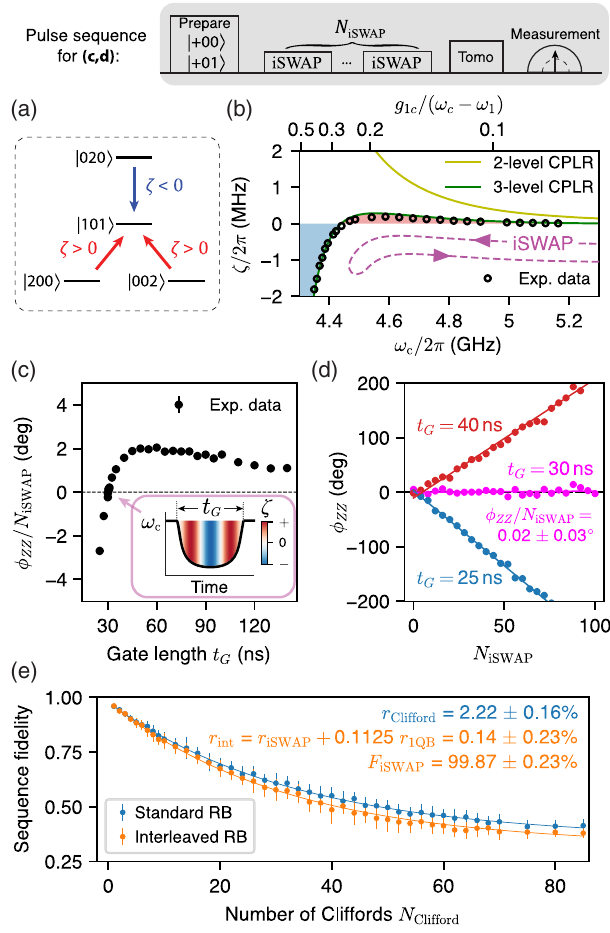
FIG. 5. Canceling out residual ZZ interaction of the iSWAP by exploiting the engineered coupler level structure. (a) The residual ZZ interaction during iSWAP originates from the level repulsion between j 101 i and the second excited level of the qubits (red arrows). This level repulsion is counteracted by utilizing the level repulsion from the second excited state of the coupler (blue arrow). (b) Residual ZZ strength ζ as a function of the , when the two qubits are on resonance. The coupler frequency ω c top x axis shows the corresponding perturbation parameter − ω = ð ω g 1 1 Þ . The solid curves correspond to numerical sim- c c ∞ (yellow) or η = 2 π ¼ − 90 MHz ulation assuming either η c ¼ c =N as a (green). (c) ZZ angle of the iSWAP gate ϕ ZZ iSWAP . We cancel out the ZZ angle by function of the gate length t G exploiting the tunability of ζ from positive to negative values. The inset shows the dynamic change of ζ during the excursion of ω c for a 30-ns-long iSWAP gate. Each data point is obtained by fitting the accumulated ZZ angle ϕ of N -times repeated ZZ iSWAP iSWAP gates with a linear function as shown in (d). (e) The results of interleaved RB for the ZZ -free 30-ns-long iSWAP gate (see the main text for details). We measure 30 random sequences ). Error bars represent (cid:1) 1 for each sequence length ( N Clifford and r ) and their standard deviations. The error rates ( r Clifford int uncertainties are extracted by performing a weighted least- squares fit using the inverse of variance as the